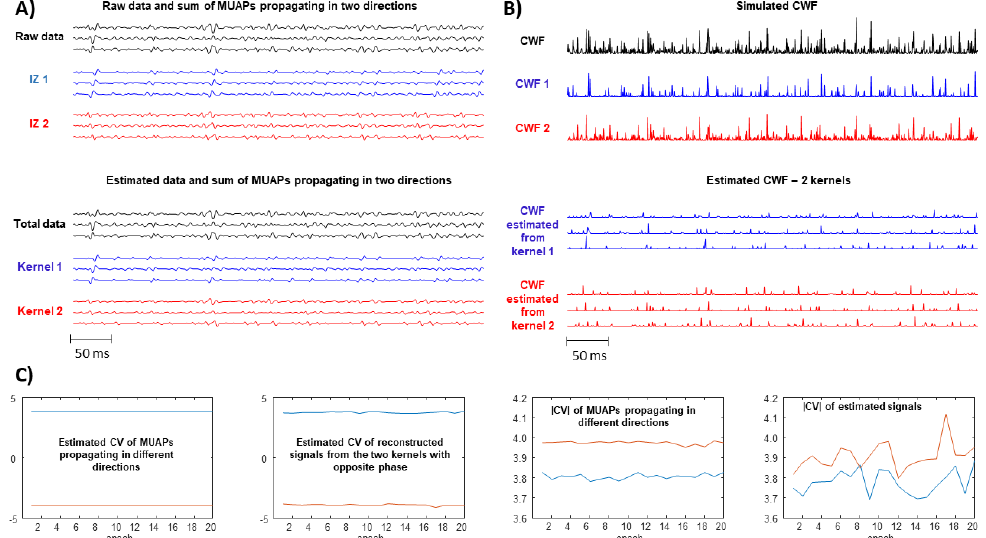
Figure 3. Example of estimation of the CV from a signal with two IZs and MUAPs propagating in two directions. A contraction level of 30% MVC was simulated, considering a volume conductor with fat layer thickness of 3 mm, mean CV of 4 m/s, no synchronization between MU firings, CoV of ISI 10%, and maximum FR 40 Hz. The smallest MUs (which were the 75% of the active MUs) were innervated in one IZ and the others were under the second one. ( A ) A portion of signal of half a second (10 s were simulated), showing three SD channels aligned to the muscle fibers. The contributions of MUAPs propagating in either of the two directions are also shown. Under the simulated signals, those obtained by deconvolution using two kernels with opposite phase are shown. ( B ) CWFs, simulated (up) and estimated (down). The estimated CWFs were obtained processing the three SD channels using the same kernels (chosen based on the first of the three SD channels, i.e., the one shown above the others). ( C ) Estimation of CV from adjacent, non overlapping epochs of 500 ms, using either the simulated or the estimated signals, corresponding to MUAPs propagating in single directions or to data deconvolved using each kernel, respectively. Both signed CV and its absolute value are